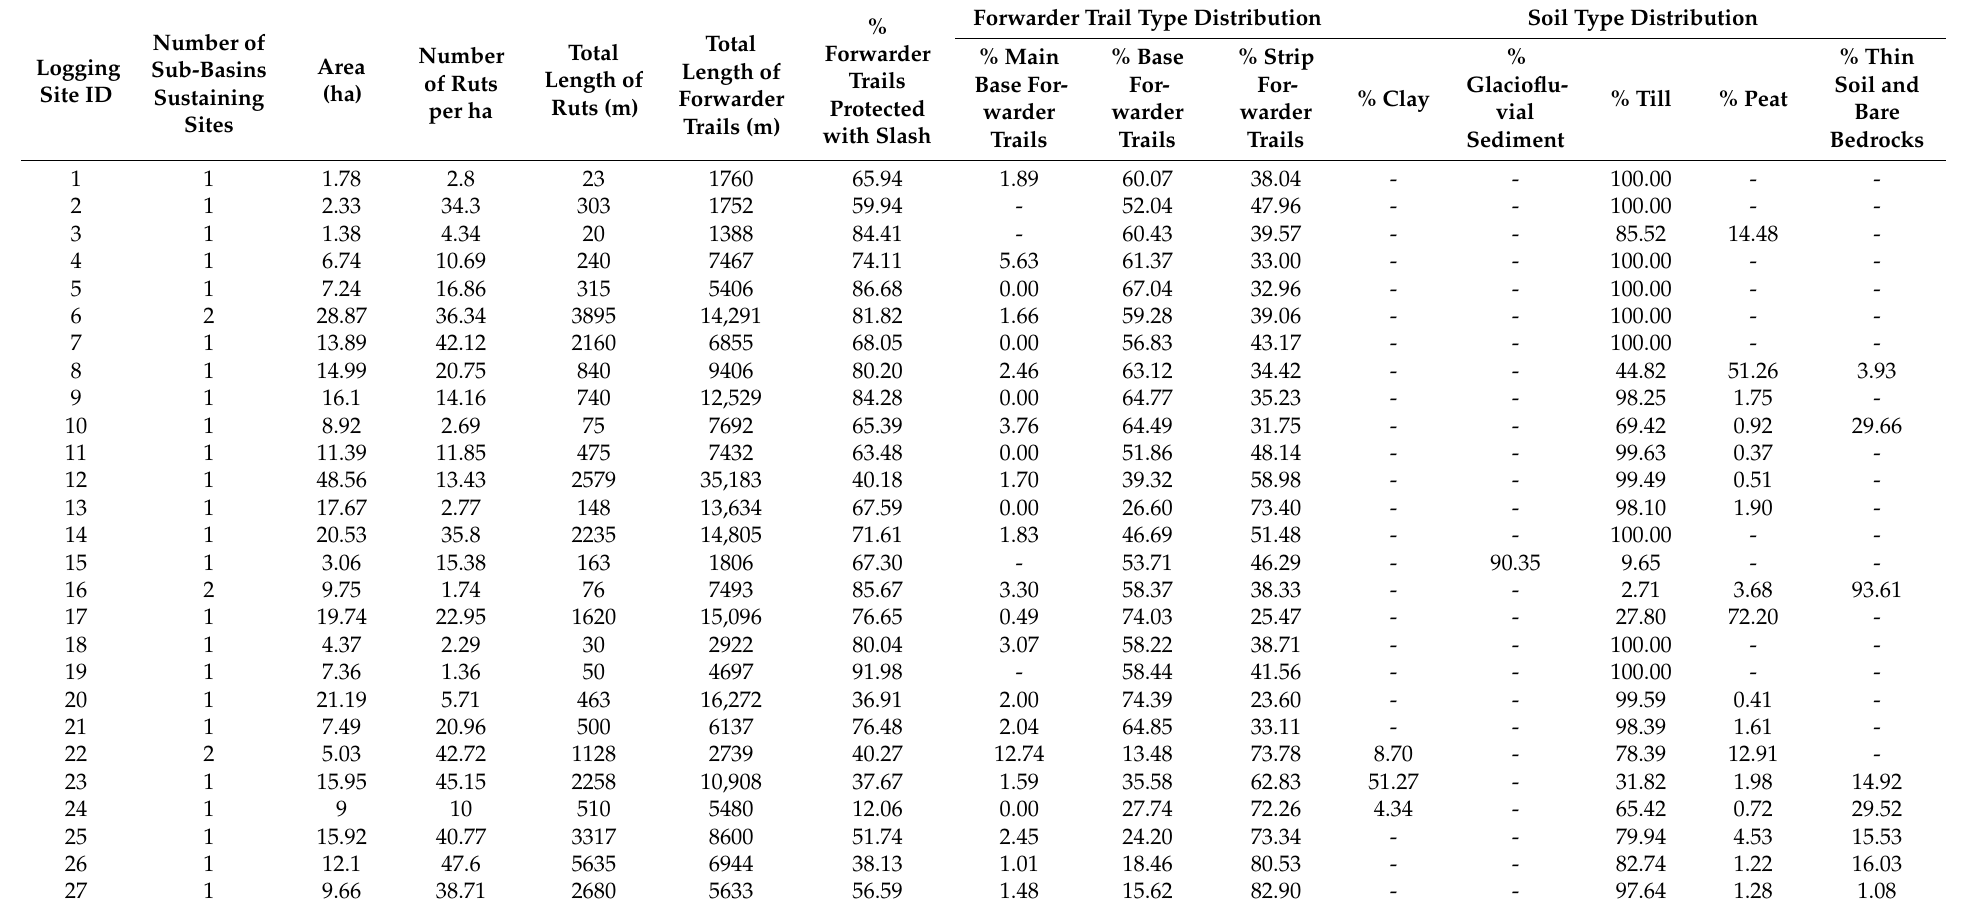
Table A1. Description of logging sites, showing number of sub-basin areas in S-HYPE, total area (ha), number of ruts per hectare, total length of forwarder trail,